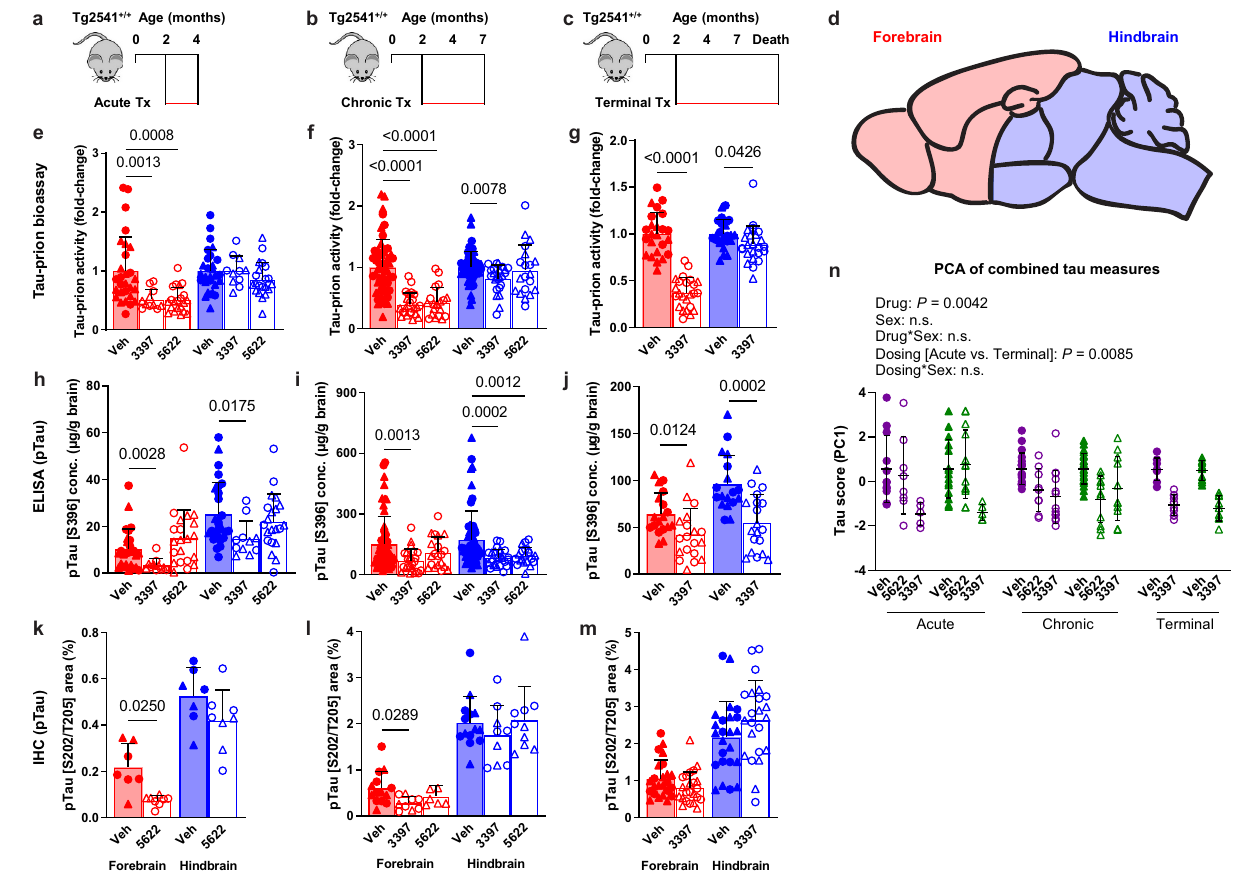
Fig. 1| CSF1Rinhibitionbythreetreatment paradigmsreducespathogenictau levels in the brains of Tg2541 mice. a – c Schematics of acute ( a ), chronic ( b ), or terminal( c )PLXtreatmentofTg2541micefrom2 – 4moofage,2 – 7moof age,or2 mo ofage untildeath, respectively. d Sagittal viewof the mouse brain divided into two regions: the forebrain, containing the cortex, hippocampus, striatum, and olfactory bulb; and the hindbrain, containing the thalamus, hypothalamus, mid- brain, cerebellum, and brain stem. e – g Tau-prion levels in forebrain and hindbrain tissue homogenates of Tg2541mice receiving acute ( e , n =28 vehicle-treated mice, 11 PLX3397-treated mice, and 21 PLX5622-treated mice), chronic ( f , n =53 vehicle- treatedmice, 24PLX3397-treated mice,and 20PLX5622-treatedmice),or terminal ( g , n =24 vehicle-treated mice and 24 PLX3397-treated mice) treatment with vehicle, PLX3397 (275mg/kg oral), or PLX5622 (1200mg/kg oral), measured using the HEK293T cell tau-prion bioassay and normalized to the vehicle-treated group. h – j Levels of pTau [S396] measured by ELISA in formic acid extracts of forebrain and hindbrain tissue homogenates of Tg2541 mice receiving acute ( h ), chronic ( i ), or terminal treatment ( j ) with vehicle, PLX3397, or PLX5622, normalized to total protein concentration. Similar numbers of mice were used as in ( e – g ). k – m Quanti fi cation of pTau [S202/T205]-positive area by IHCanalysisofforebrain and hindbrain areas of Tg2541 mice receiving acute ( k , n =7 vehicle-treated mice and 8 PLX5622-treated mice), chronic ( l , n =14 vehicle-treated mice, 9 PLX3397- treated mice, and 10 PLX5622-treated mice), or terminal ( m , n =24 vehicle-treated mice and 23 PLX3397-treated mice) treatment with vehicle, PLX3397, or PLX5622.